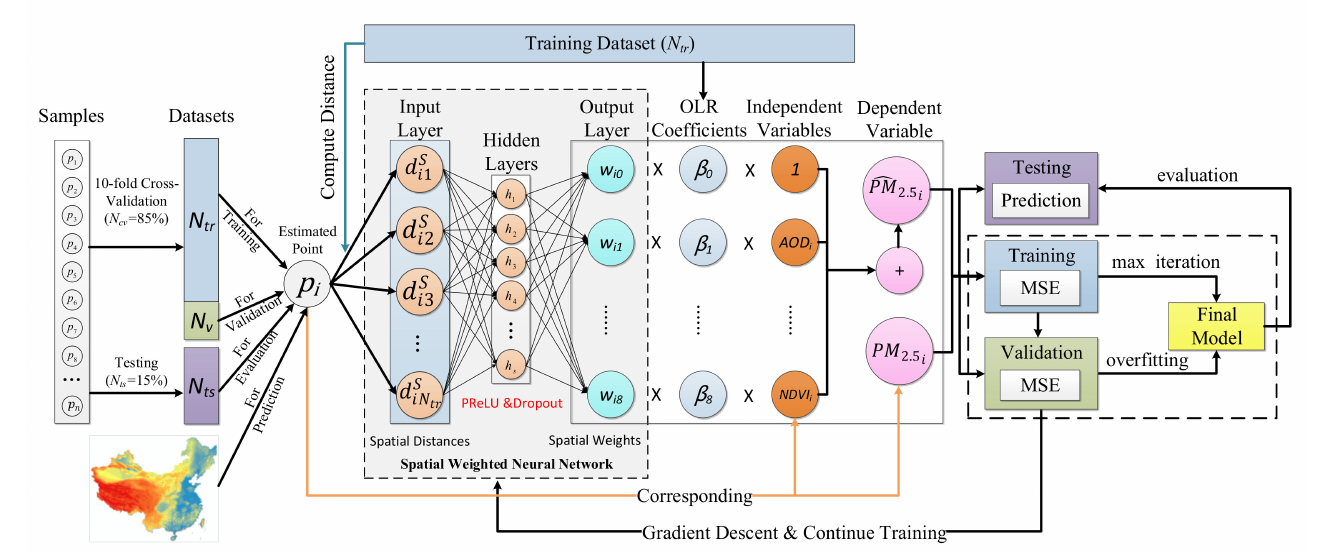
Figure 2. The framework of the GNNWR model for PM 2.5